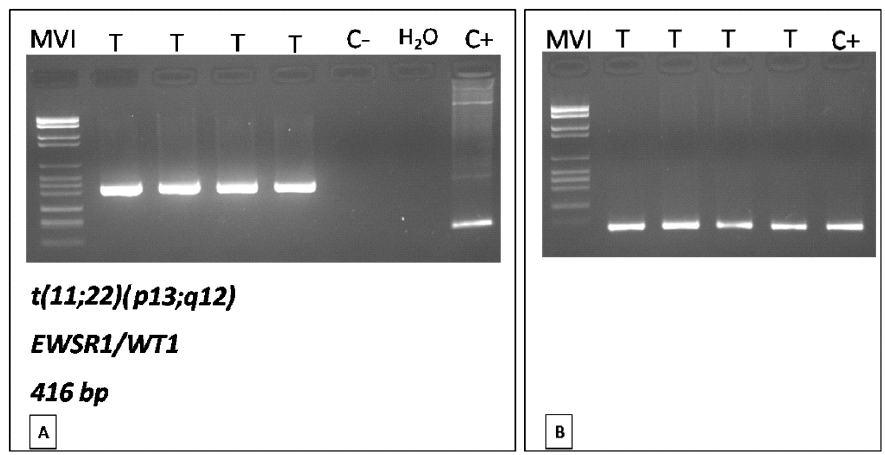
Figure 4. ( A ) RT ‐ PCR analysis revealing the presence of the EWSR1 ‐ WT1 chimeric transcript, Figure 4. ( A ) RT-PCR analysis revealing the presence of the EWSR1-WT1 chimeric transcript, char-